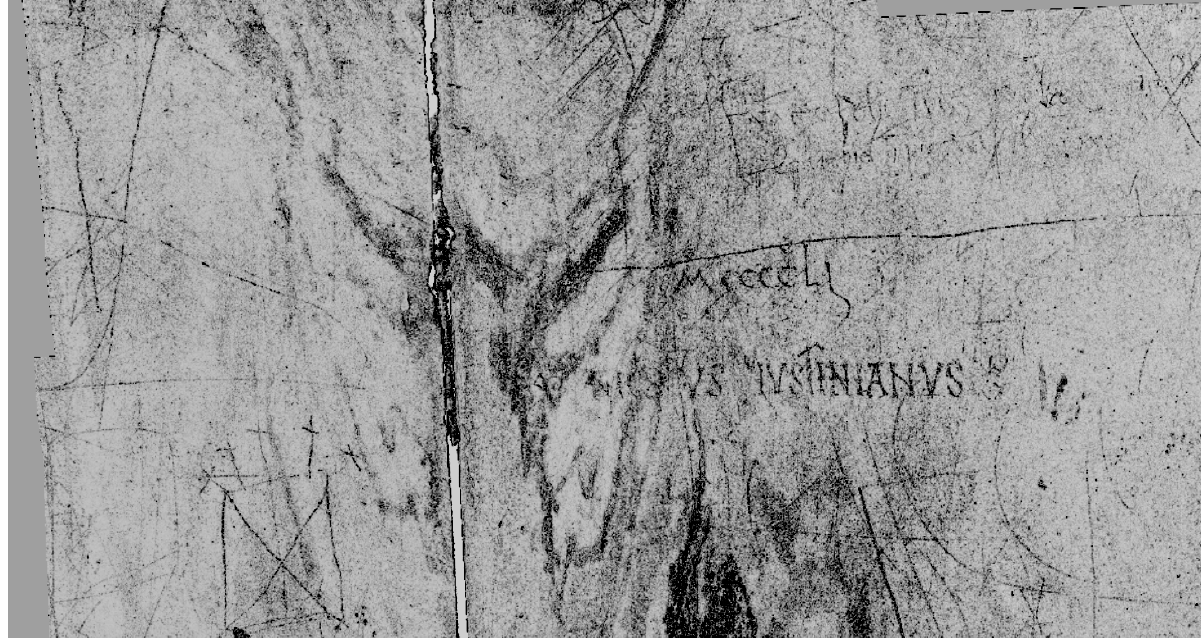
Figure 7. San Marco Basilica, pillar, orthophoto, inscription detail,